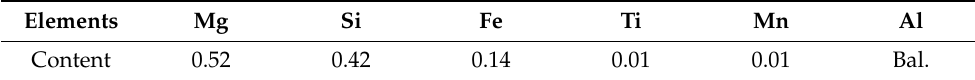
Table 1. Chemical composition of the investigated Al-Mg-Si alloy (wt.%). Elements Mg Si Fe Ti Mn Al Content 0.52 0.42 0.14 0.01 0.01